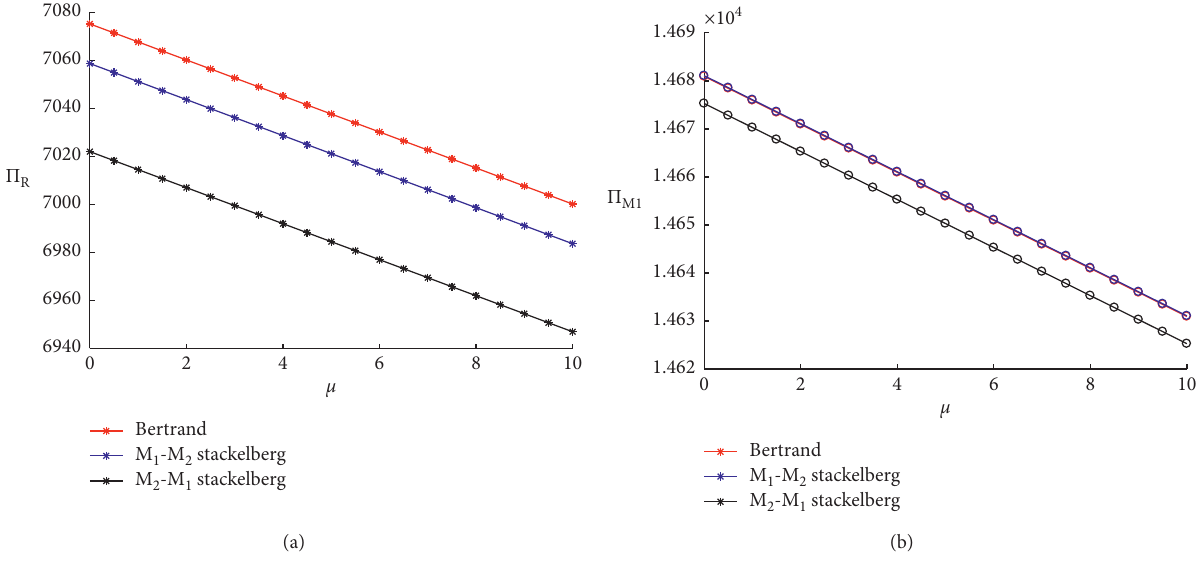
Figure 6: Influence of μ on profit functions under different